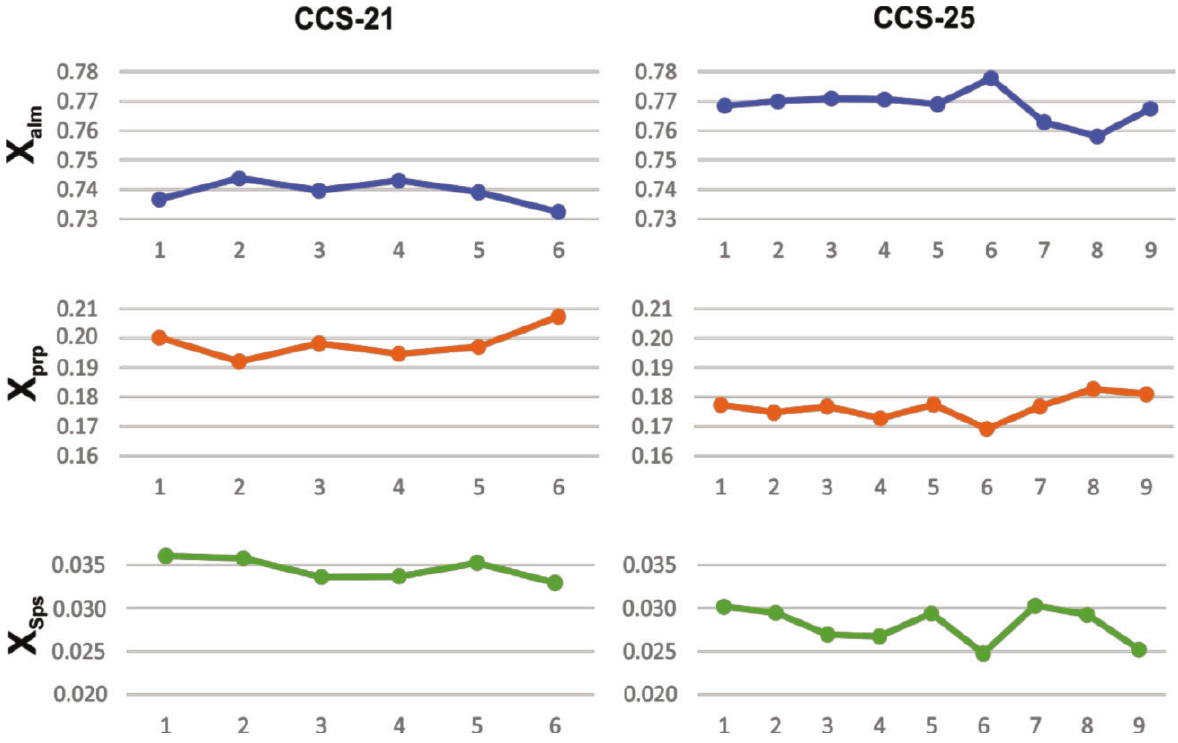
Figure 8. Chemical profile in garnets showing content of X